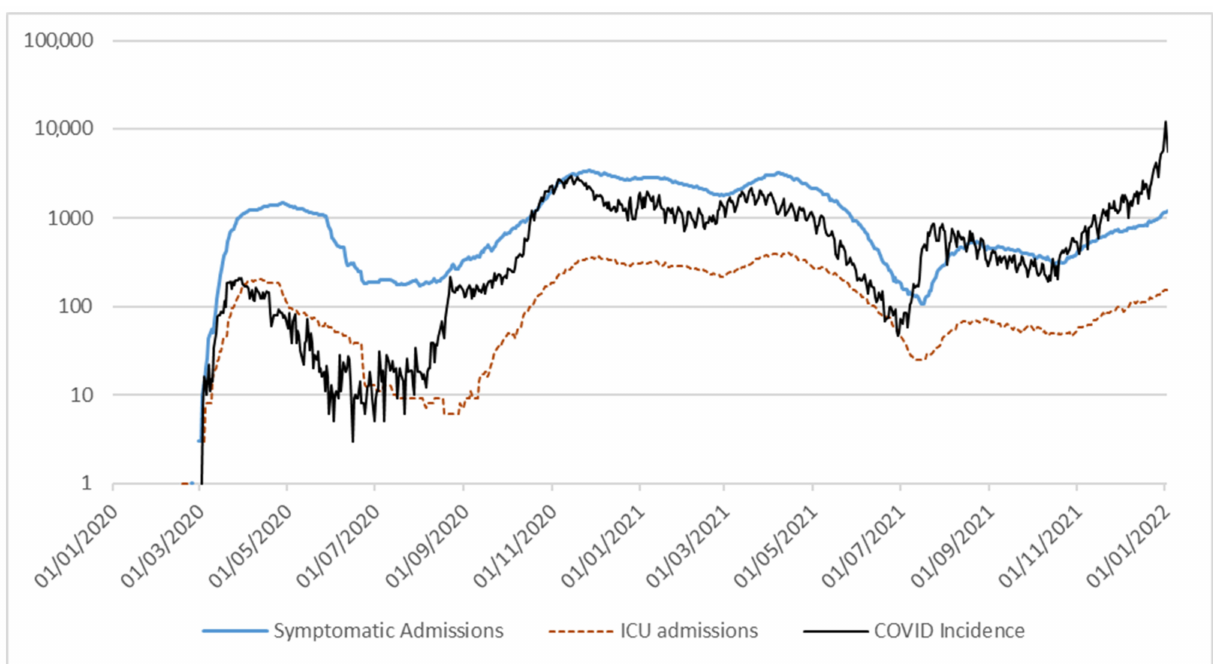
Figure 2. Hospital and ICU admissions, and COVID-19 incidence in Lazio region, Italy, 2020–2021 (log